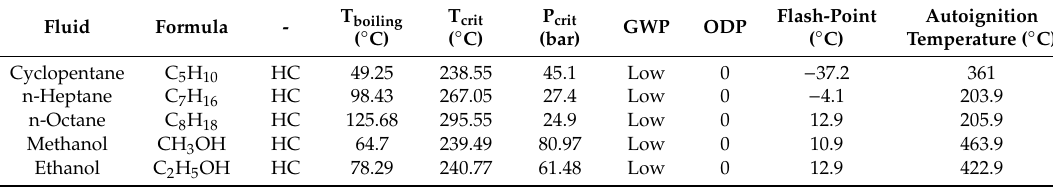
Table 6. Main properties of selected organic